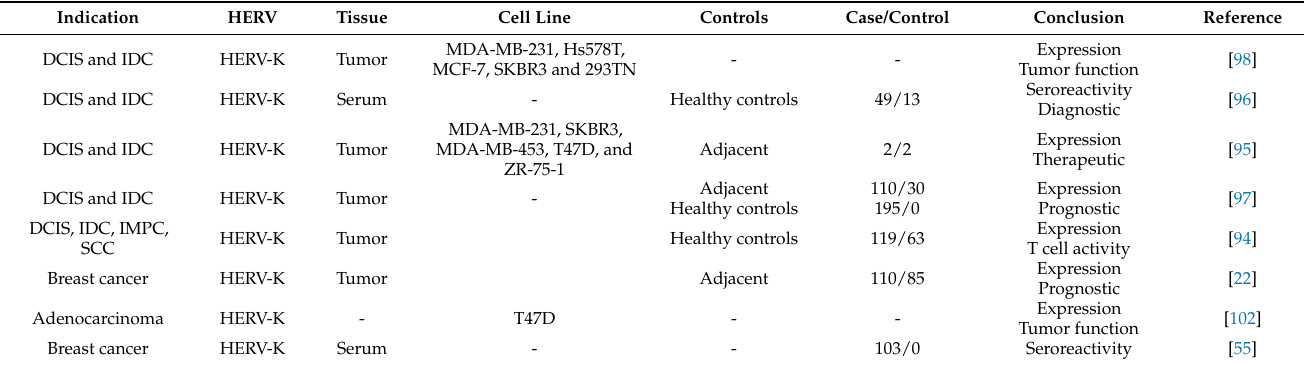
Table 6. HERV protein expression in mammary